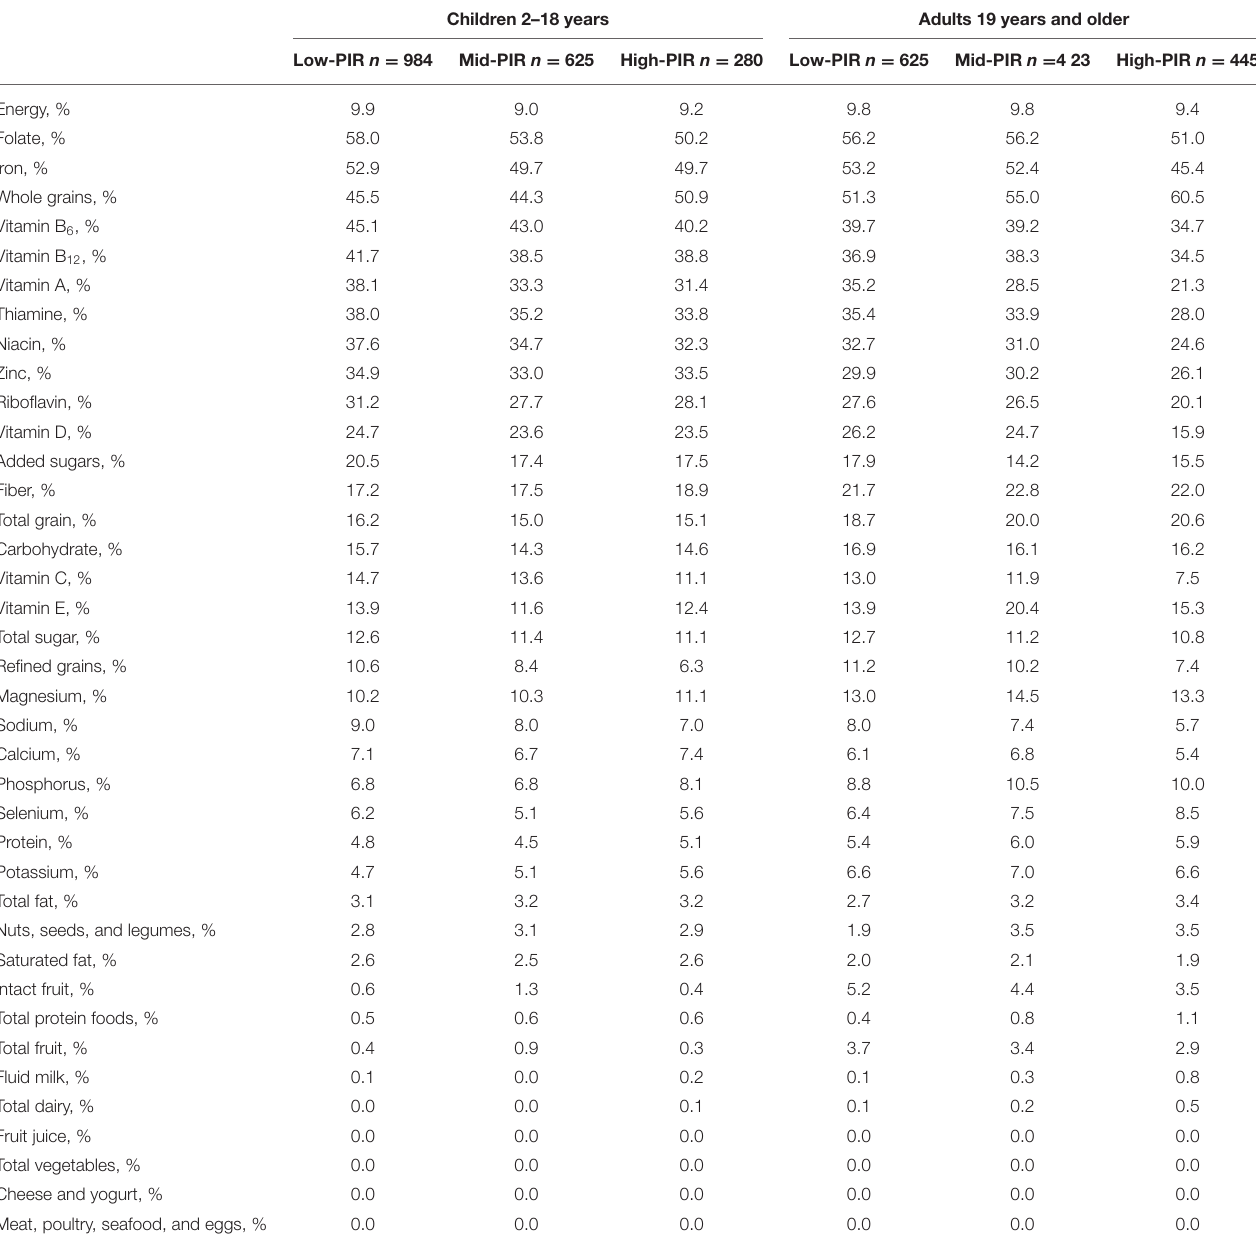
TABLE 5 | Percent contribution of RTE cereal to daily intake of nutrients and food groups for RTE cereal eaters, stratified by age and Poverty-to-income (PIR) category a